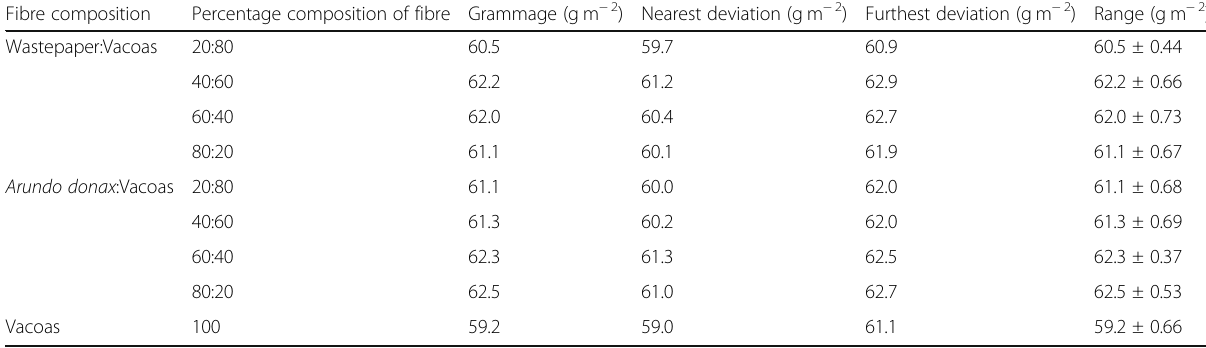
Table 1 Mean grammage for the different test specimens Fibre